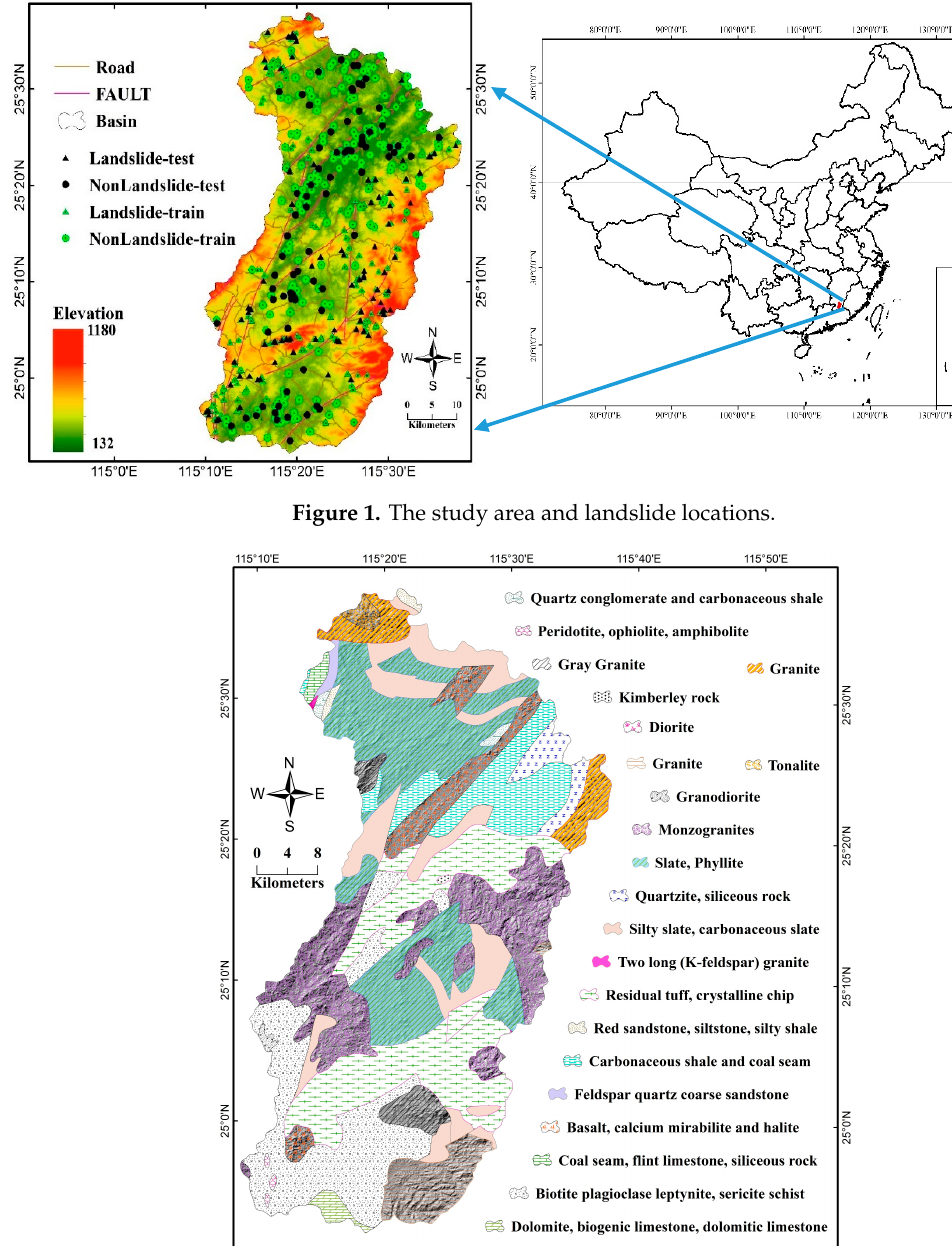
Figure 1. The study area and landslide locations.